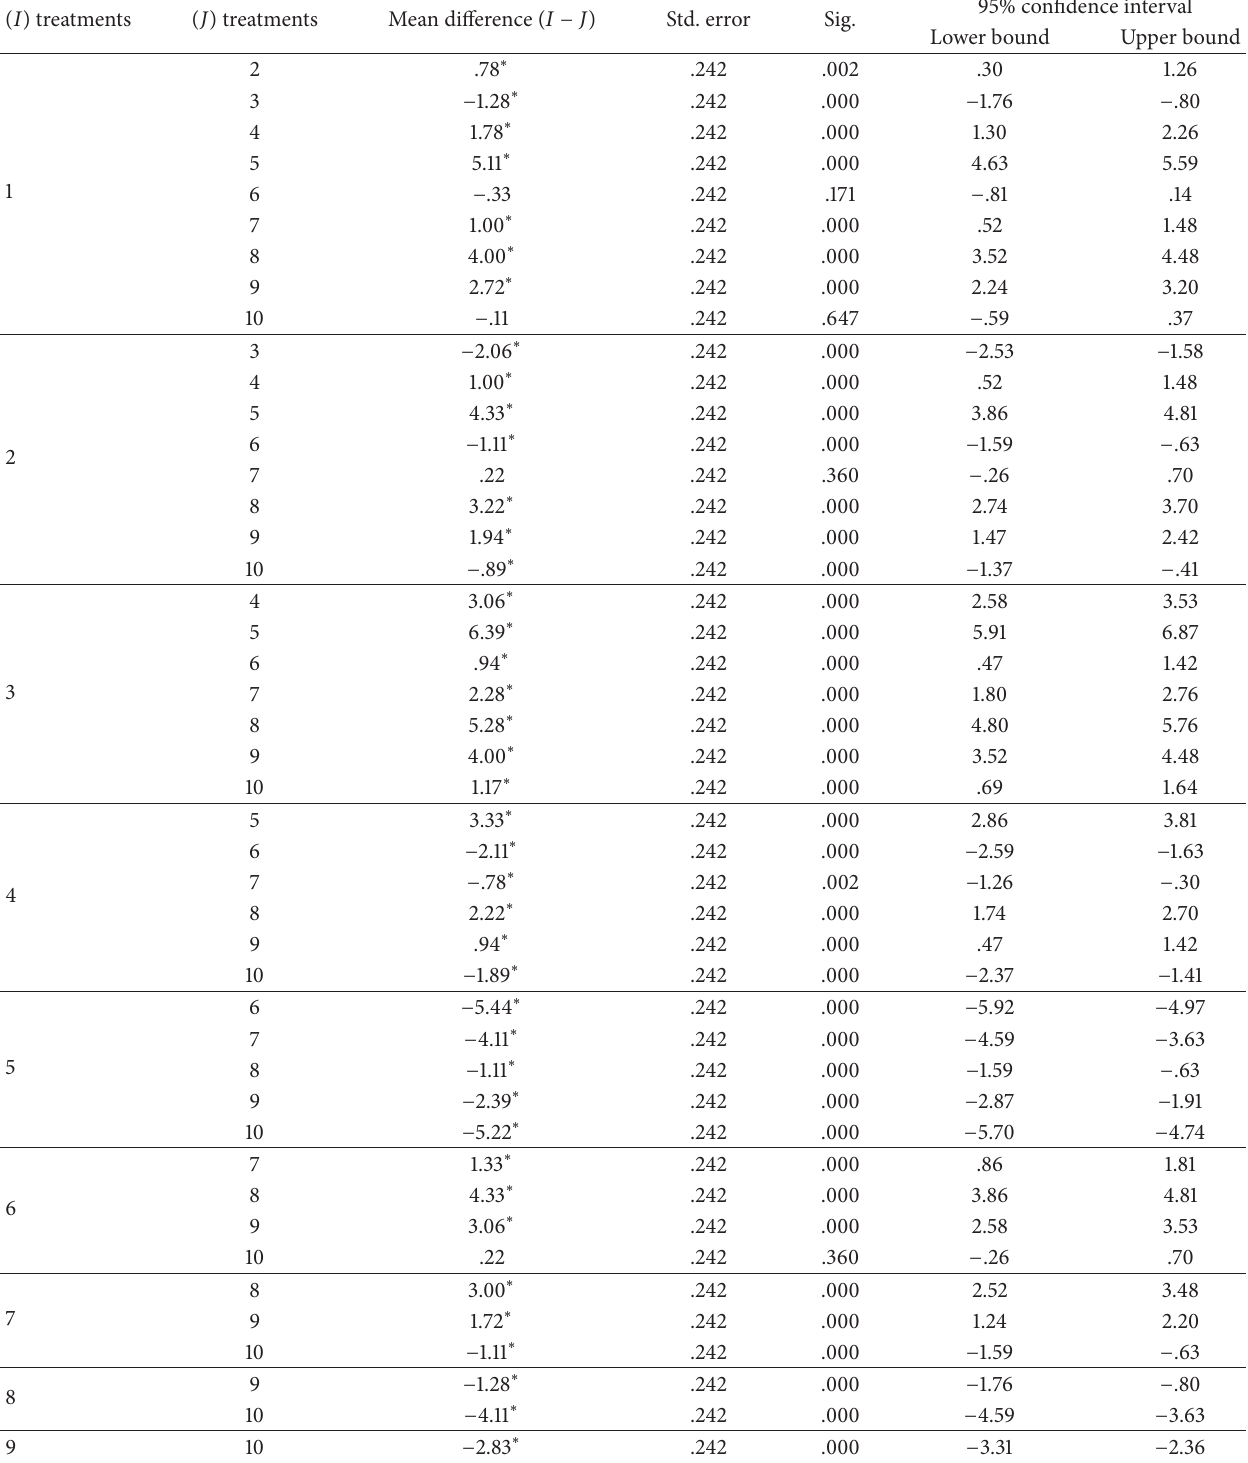
Table 3: Multiple comparisons among different insecticidal treatments against adult females of hibiscus mealybug in laboratory bioassay. (𝐼 ) treatments ( 𝐽 ) treatments Mean difference ( 𝐼 − 𝐽 ) Std. error